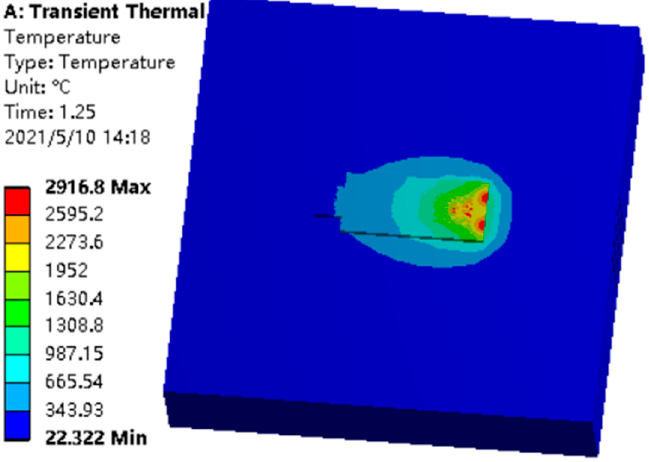
Figure 9. Transient thermal simulation of multiple laser beams working together.